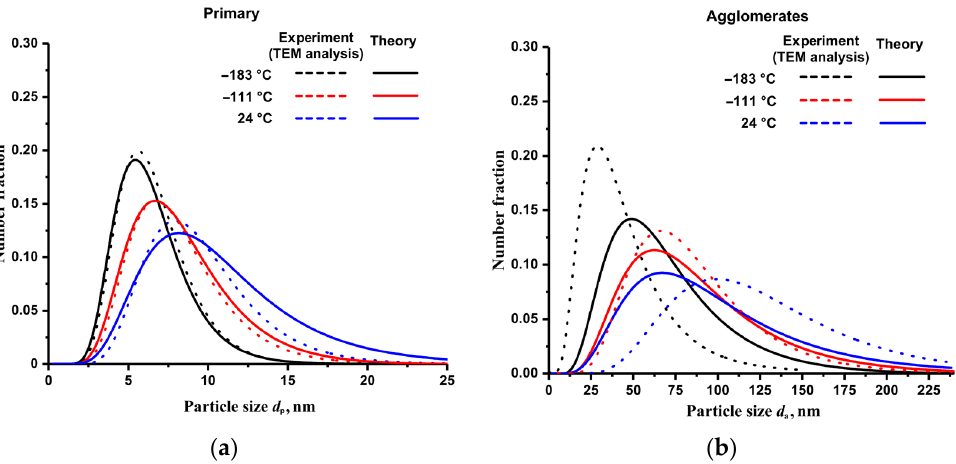
Figure 4. Distribution of primary particles ( a ) and agglomerates ( b ) by size at nitrogen carrier gas temperatures of 24 °C, −111 °C, and −183 °C, plotted from experimental (TEM analysis) and theoretical data.